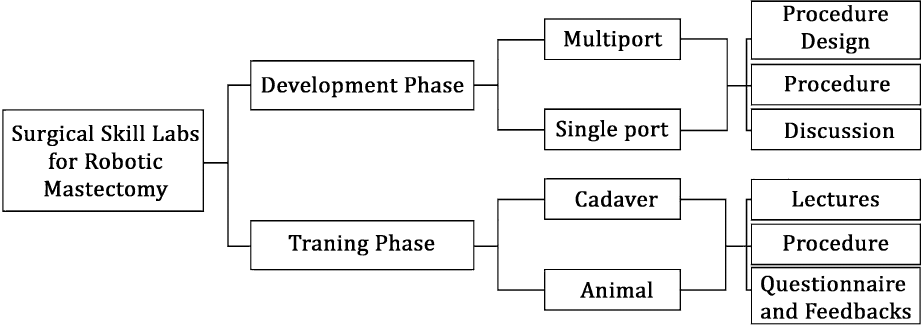
Figure 1. Categories of surgical skill laboratory training programs for robotic